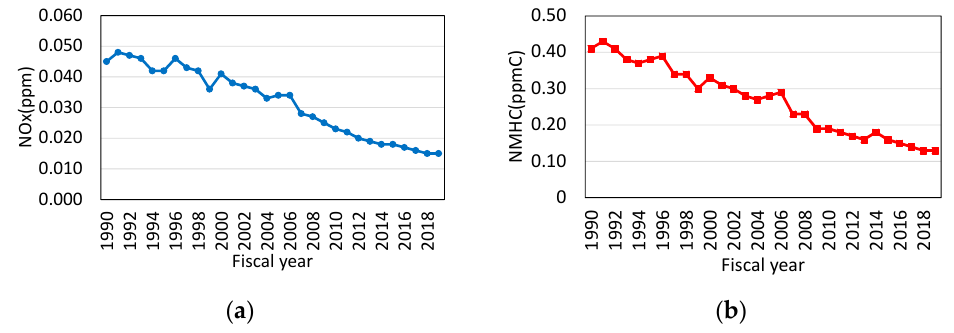
Figure 31. Trends in NOx and NMHC from April to October. ( a ) NOx: annual averages of hourly NOx for all nine General sta. from April to October. ( b ) NMHC: annual averages of hourly NMHC for seven General sta. from April to October.